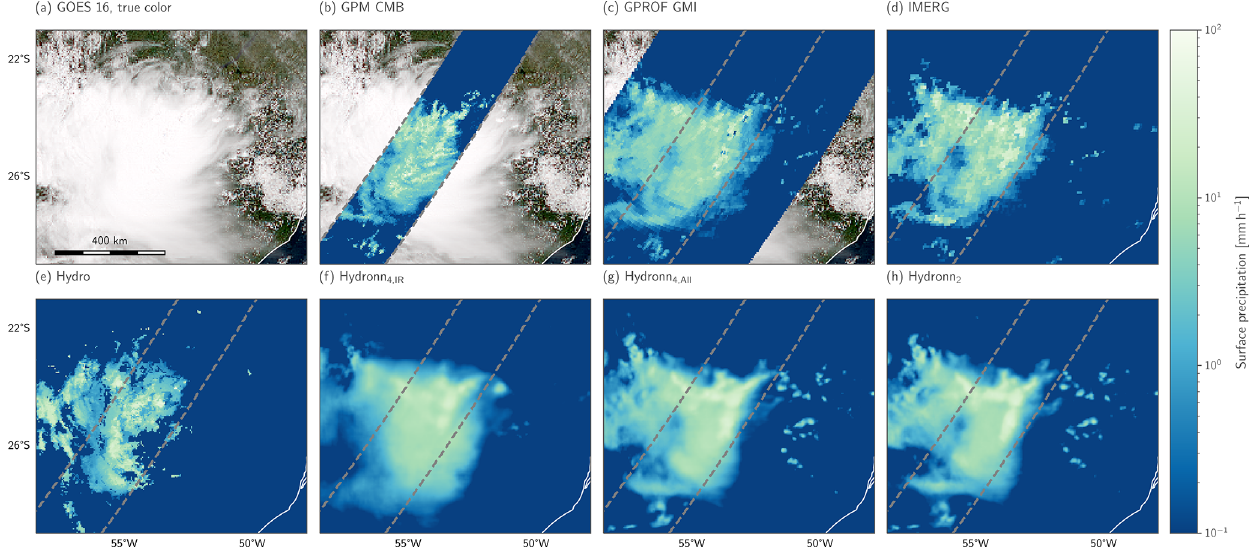
Figure 7. A mesoscale convective system over the border region between Argentina, Paraguay, and Brazil on 16 December 2020 observed by GPM and GOES-16. Panel (a) shows a natural color composite (generated using Raspaud et al., 2021). Panel (b) shows retrieved surface precipitation from CMB retrieved using combined radar and passive microwave observations. Panel (b) shows precipitation retrieved by GPROF GMI using only passive microwave observations. Panel (c) shows the surface precipitation from the IMERG Final product. Panel (d) shows surface precipitation retrieved by HYDRO from GOES ABI observations. Panels (e) , (f) , and (g) show the corresponding results from the three Hydronn configurations. Table 2. Retrieval accuracy metrics for the MCS overpass shown in Fig. 7. Definitions of all metrics can be found in Appendix A1. Bold font marks the best results for each metric. Retrieval Bias MAE